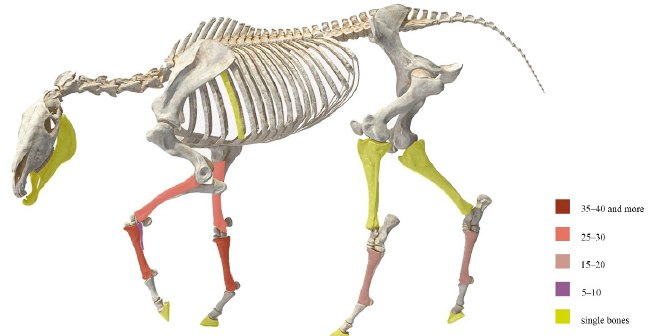
Figure 2. The use of horse skeleton parts for production in the early Middle Ages. Horse skeleton according to https://www.turbosquid.com/pl/3d-models/3d-horse-skeleton-rigged-model-1379277, with modifications (number of artefacts).